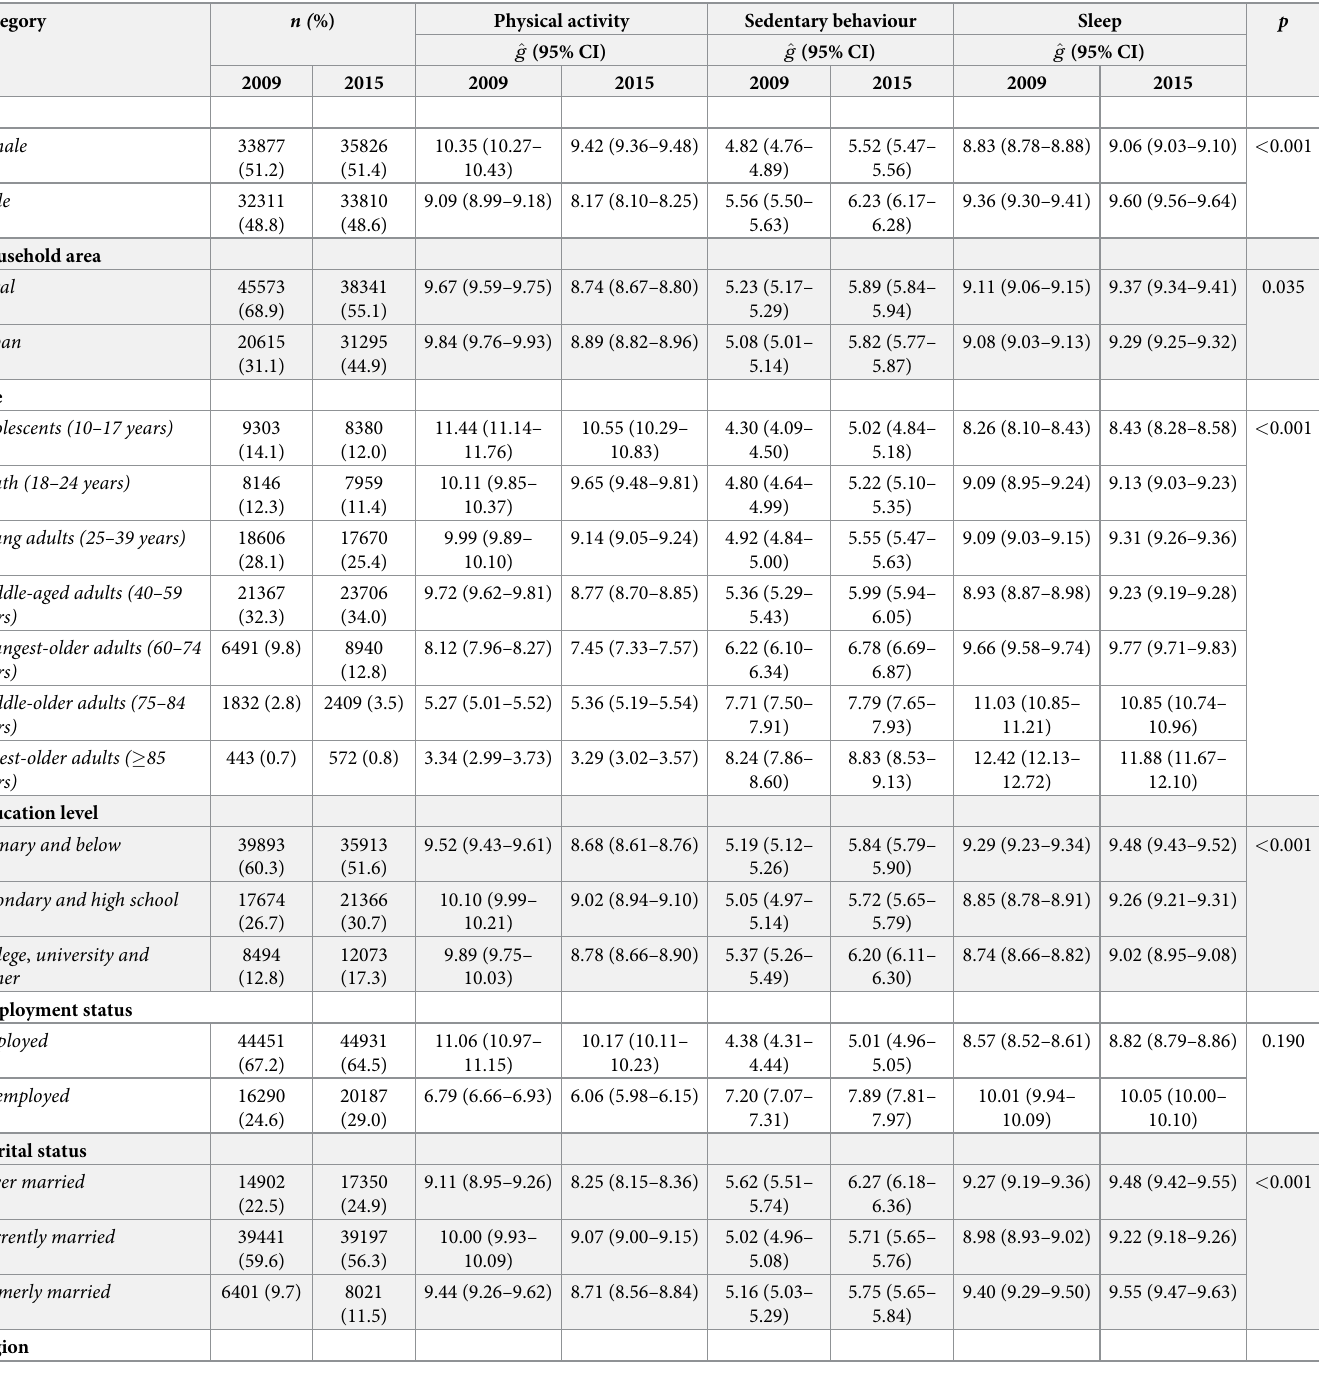
Table 1. Time (h/day) spent in physical activity, sedentary behaviour and sleep in the Thai population.